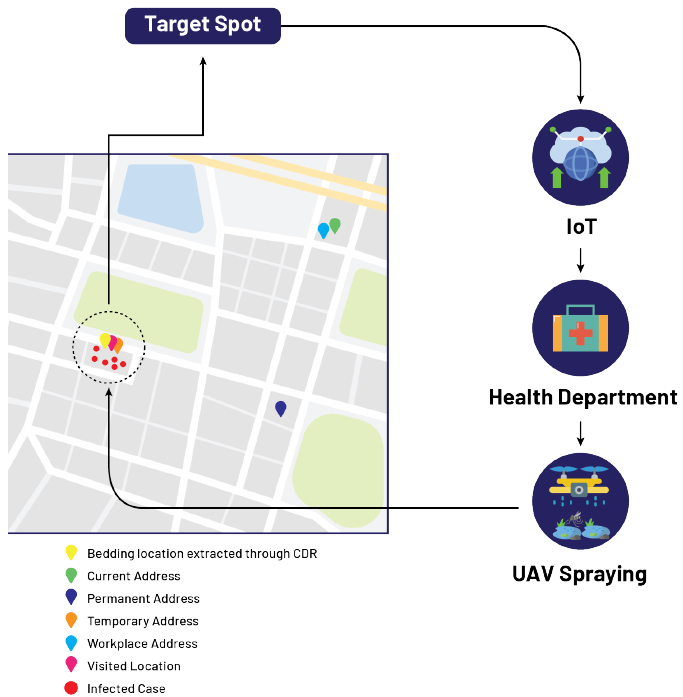
Figure 6. Localization of target spot based on proposed model.